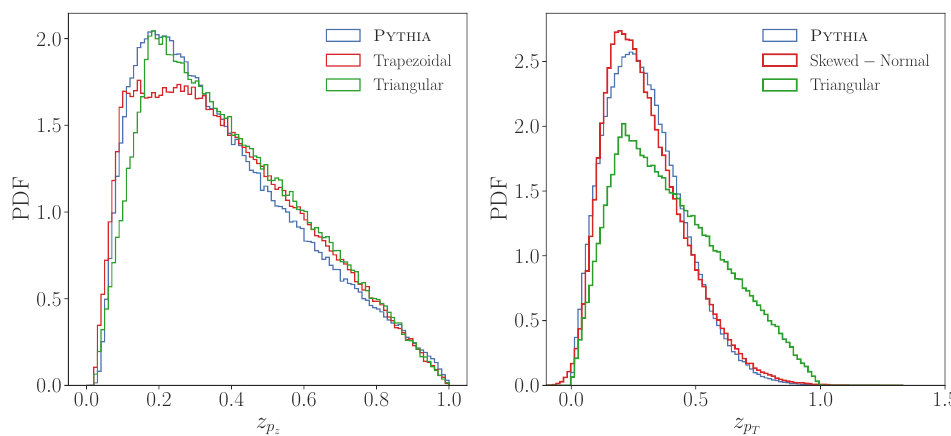
Figure 7: Three choices for latent-space target distributions I ( z , c ) for p ′ and for p inputs (right). See Appendix C for more T